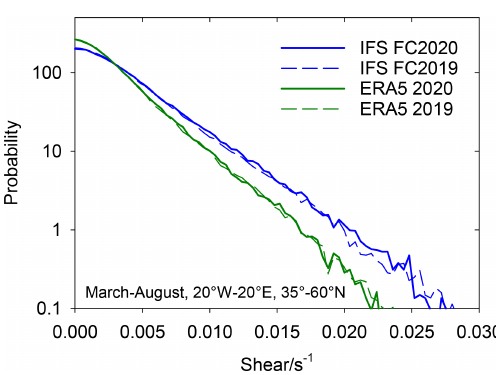
Figure 5. Probability density of vertical shear of horizontal wind normal to flight segments along the traffic routes over Europe as in 2020, evaluated separately for the FC and ERA5 meteorology as in Fig.